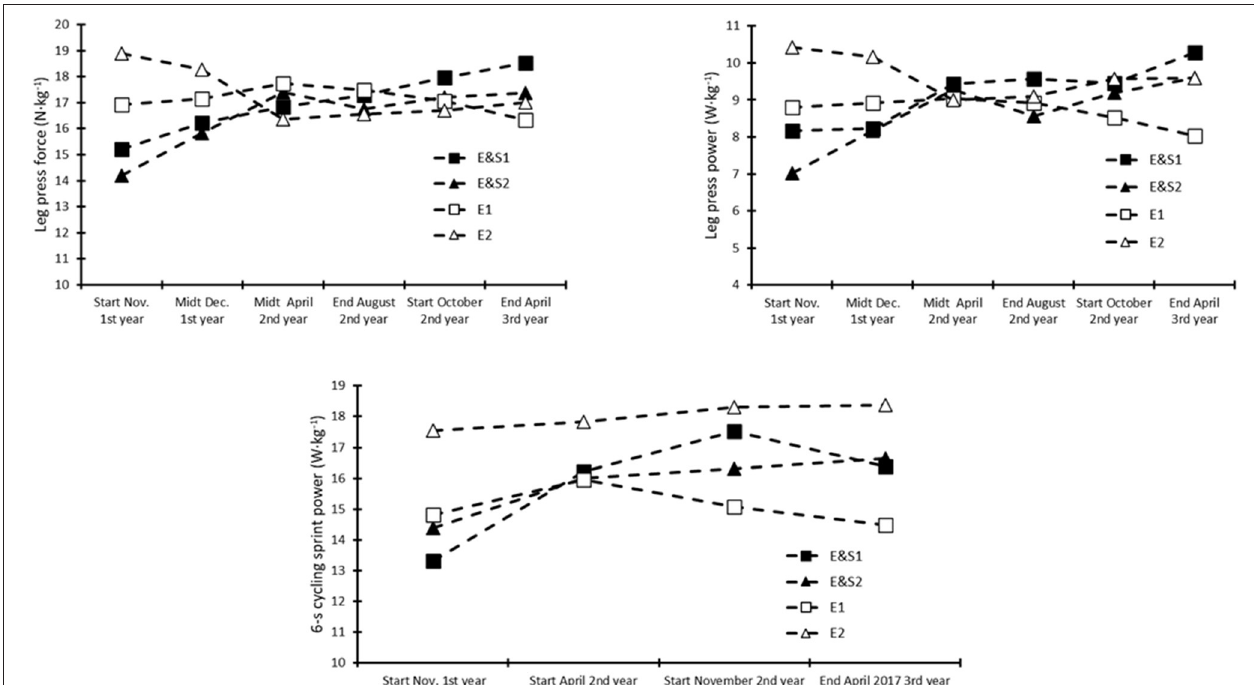
FIGURE 3 | Leg press force (upper left panel), leg press power (upper right panel), and 6-s cycling sprint mean power (lower panel) of the two cyclists who started with heavy strength training ( EandS ) and the two cyclists who continued endurance training only ( E ). Data start with the preparatory period (November) via the competition period (starting in April) and the new preparatory period (starting in October) and conclude at the start of the following competition period (April), altogether lasting for 1.5